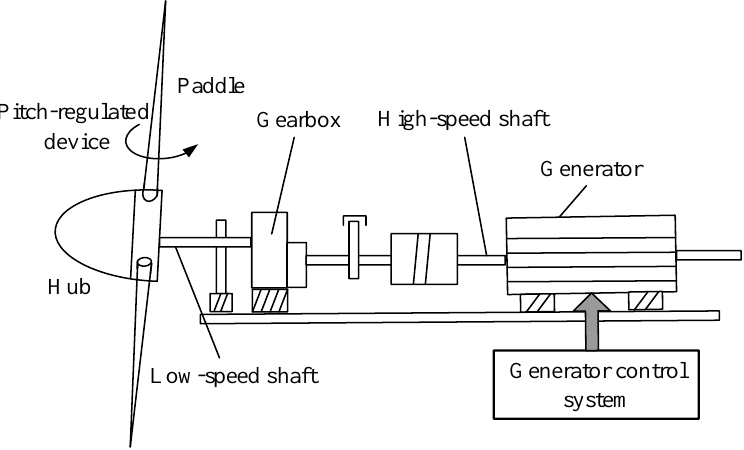
Figure 1. A schematic diagram of the wind power system. The gearbox in Figure 1 is regarded as an equivalent gear. The mass of the driving gear is converted to the wind turbine side, and the mass of the driven gear is converted to the generator side. The gear clearance influence of the three-stage gear system in the gearbox is represented by an equivalent total clearance to ensure that a two-mass drivetrain model with gear clearance can be obtained (Figure 2).